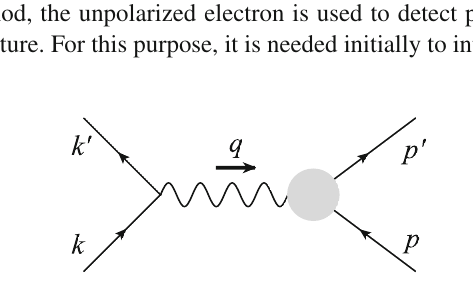
Fig. 1 Typical schematic of Feynman diagram for electron-proton elastic scattering. Bubbled vertex indicates proton